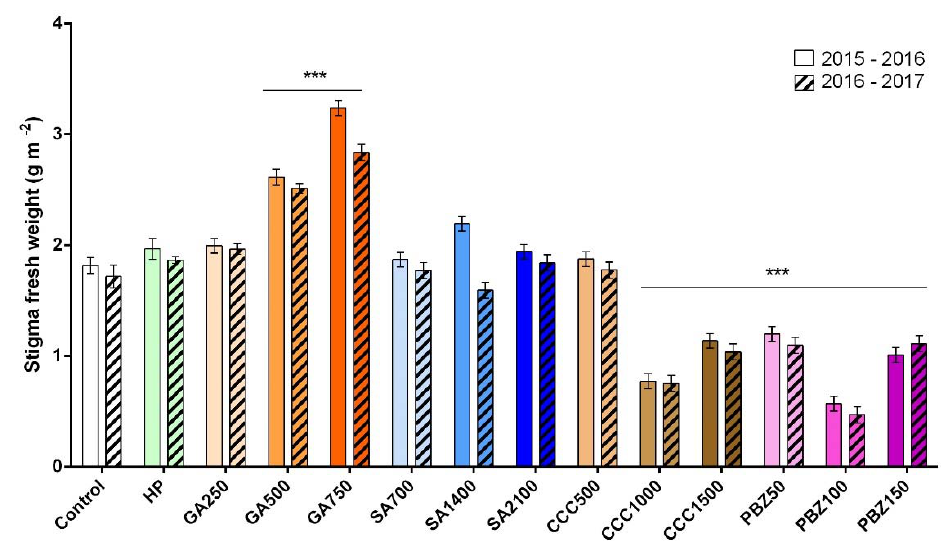
Figure 4. Effects of corm priming with distilled water and four different growth regulators on stigma fresh weight of saffron plants grown under field condition. HP, hydropriming; GA, gib ‐ berellic acid; SA, salicylic acid; CCC, chlormequat chloride; PBZ, paclobutrazol. Data are shown as mean ± standard deviation; *** p < 0.001 vs. control group. The empty white and colored columns correspond to the data for the years 2015–2016. The white and colored columns with oblique lines correspond to the years 2016–2017.